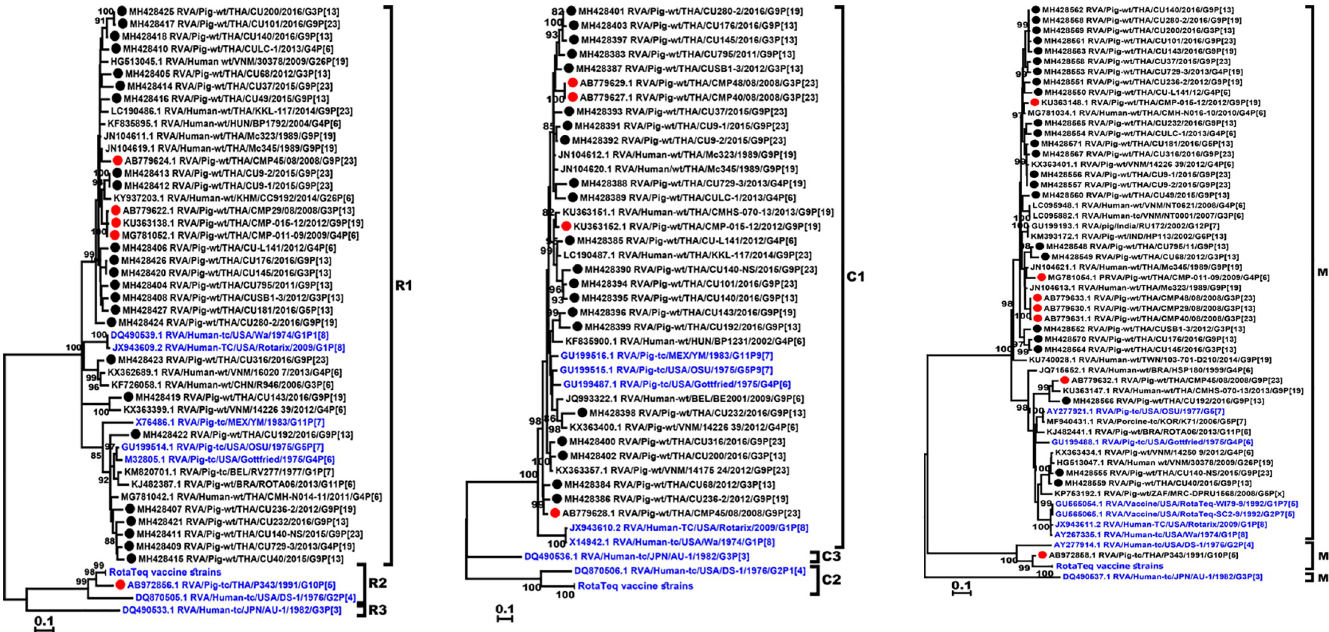
Fig 4. Phylogenetic analysis of the RVA VP1, VP2, and VP3 genes. The nucleotide sequences of the Thai strains (dotted) were compared to those of previous Thai porcine RVA strains (red dotted), the RVA reference and vaccine strains (blue).